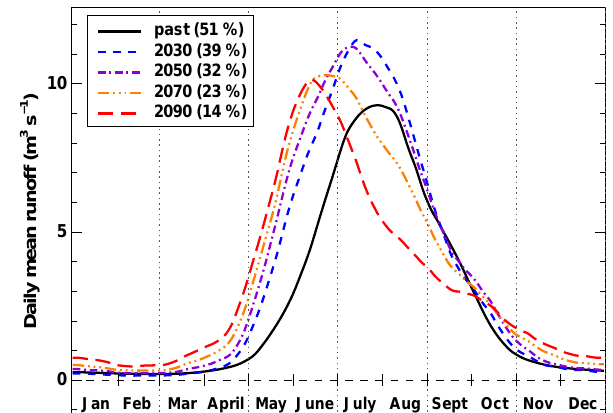
Fig. 13. Projected change in the hydrological regime of the Rhonegletscher catchment according to Scenario 2 (median). Measured discharge in the past refers to the 1961-1990 average. Numbers in brackets indicate the glacierization of the drainage basin.